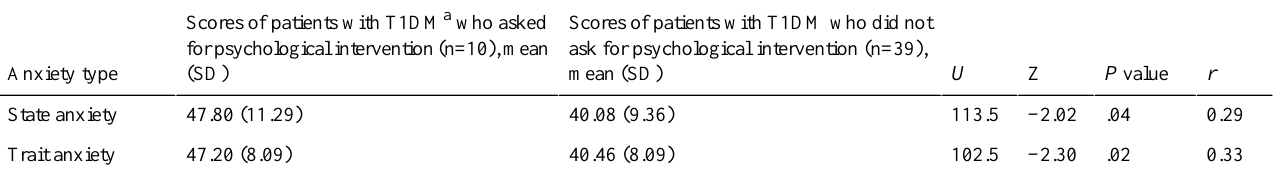
Table 1. Level of anxiety in the examined groups.